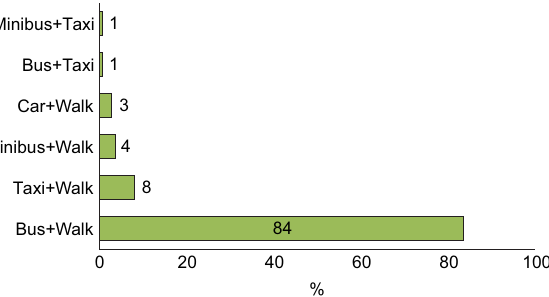
Fig. 2. Travelling by purpose, May 2018.